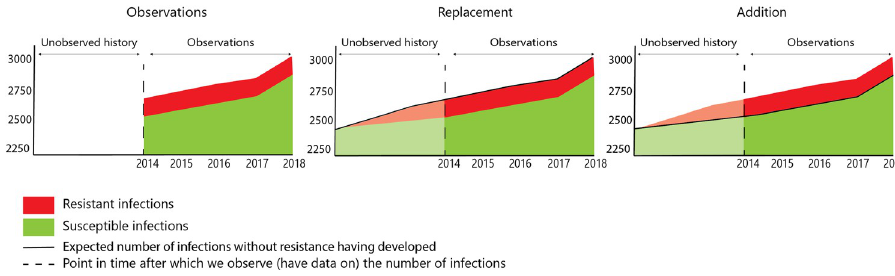
Fig 2. Number of susceptible E. coli and ESBL E. coli bacteraemia in 24 Dutch hospitals from 2014 to